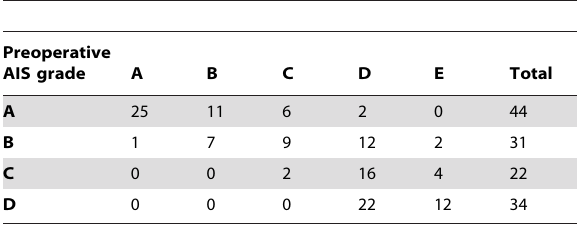
Table 4. Ordinal changes in AIS grade from pre-op to 6 months follow-up: Early Surgery